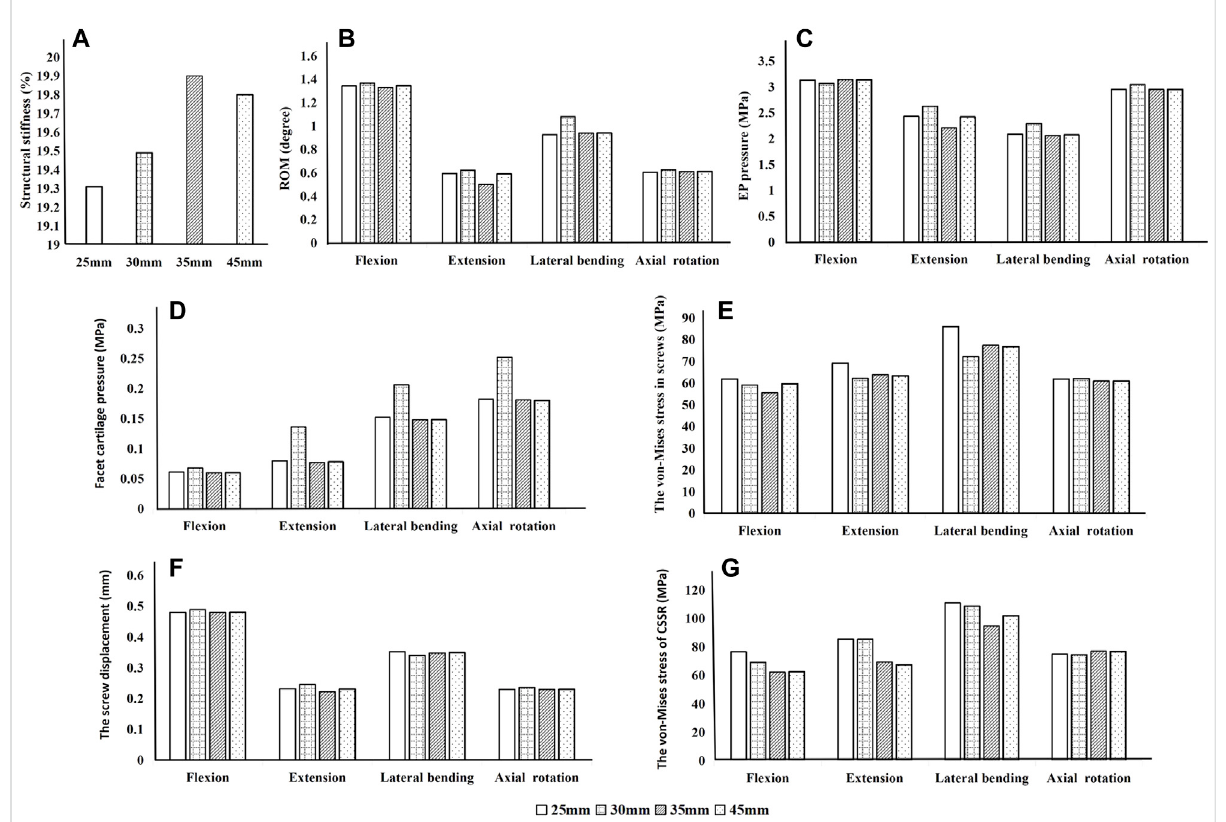
FIGURE 6 Parametersofthemodelsfordifferentrodlengthswhenplacedunder fl exion,extension,lateralbending,andaxialrotation. (A) Axialstiffness, (B) ROM, (C) von-Mises stress on endplates, (D) von-Mises stress on facet cartilage, (E) von-Mises stress on pedicle screws, (F) displacement of pedicle screws, and (G) von-Mises stress at the contact surface between the screw and rod